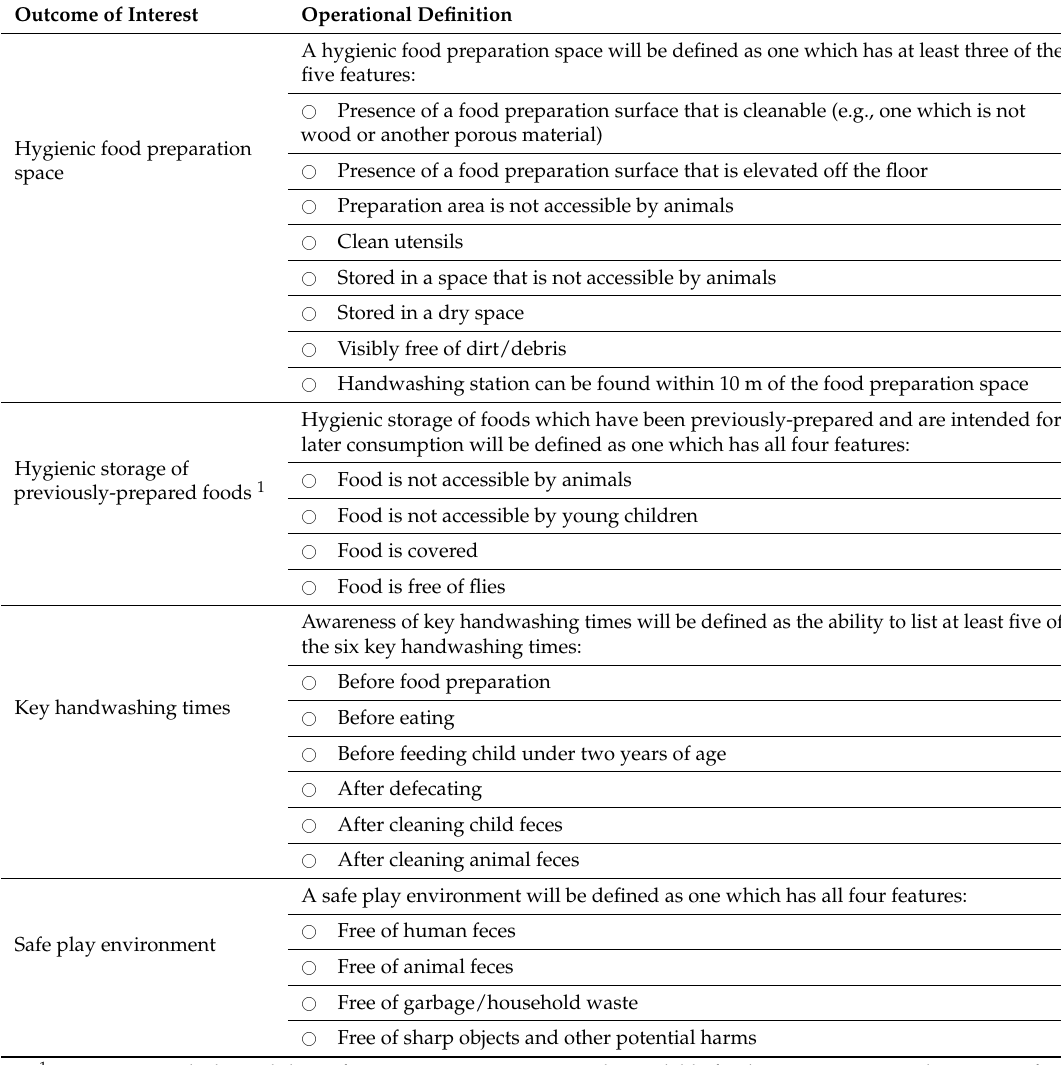
Table 1. Operational definitions for hygiene-related outcomes of